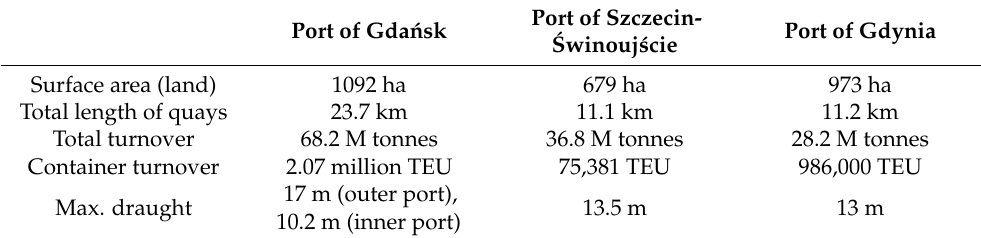
Table 8. Selected parameters for the ports as of